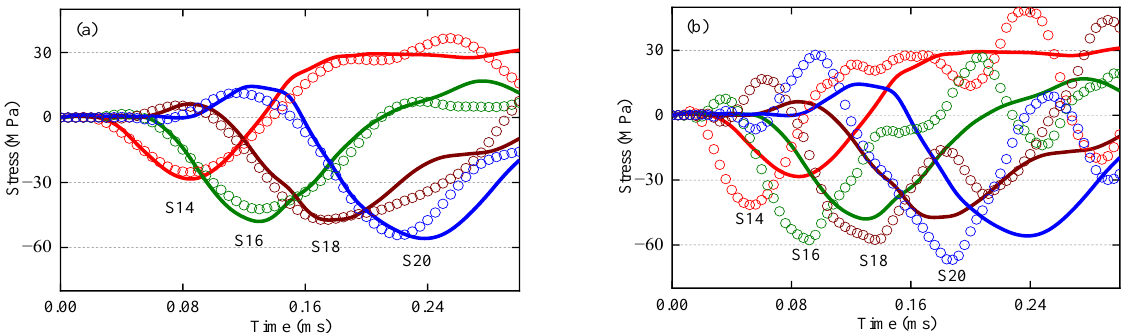
Figure 8. Stress responses of the 51st impact (first impact of H = 210 mm): ( a ) Experimental results (Solid line) and eigenfunction method results (Scatter) with ML model; ( b ) Experimental results (Solid line) and eigenfunction method results (Scatter) with CYM model.